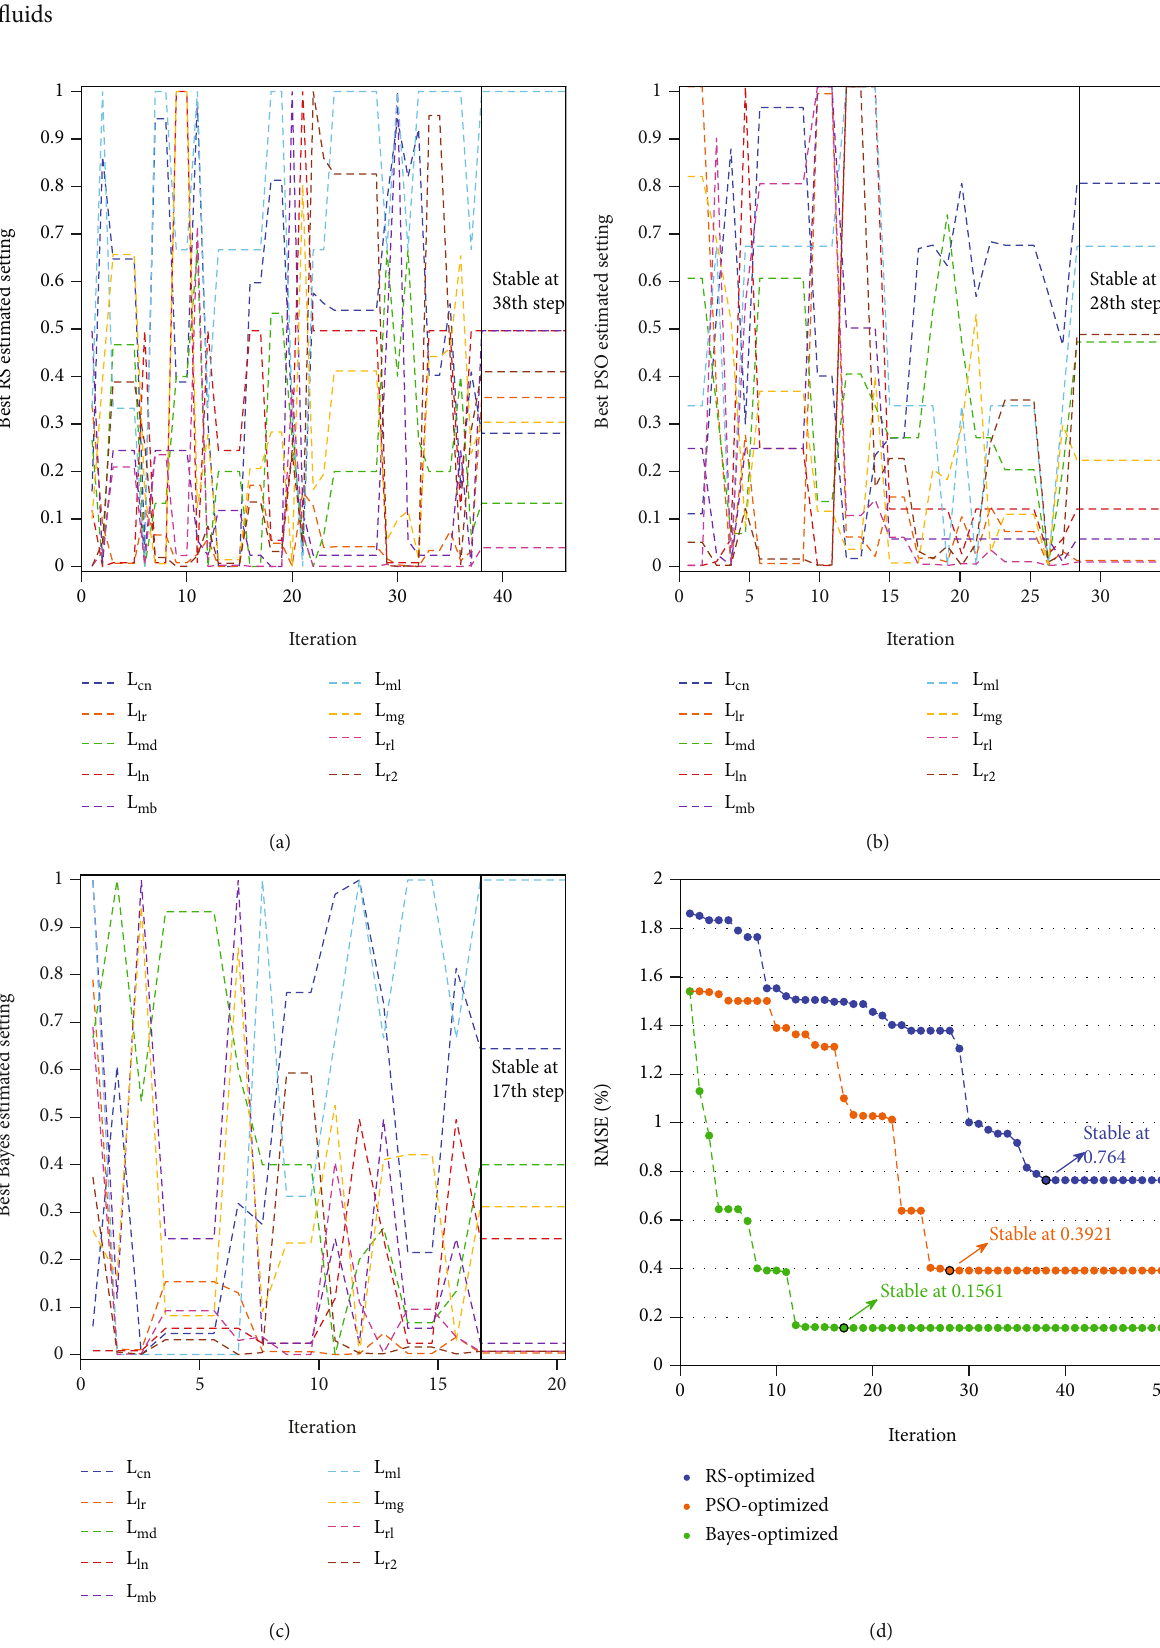
Figure 7: Variations of hyperparameters of light gradient boosting machine (LightGBM) implemented by RS (a), PSO (b), and Bayes (c), and downtrends of RMSE of porosity values generated by three applied optimizers during the whole iteration (d). RS=random research; PSO=particle swarm optimization; Bayes =Bayesian optimization; RMSE=root-mean-square